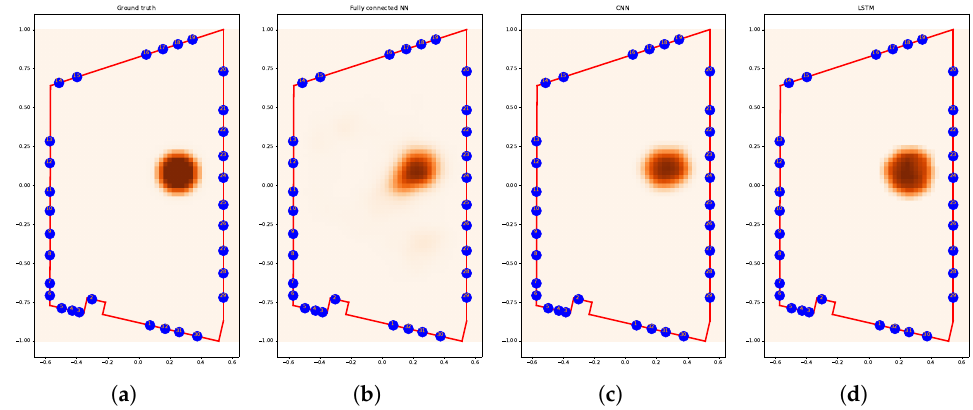
Figure 16. Reconstructions from the third test measurement. ( a ) Ground truth. ( b ) Fully connected NN. ( c ) CNN. ( d ) LSTM.